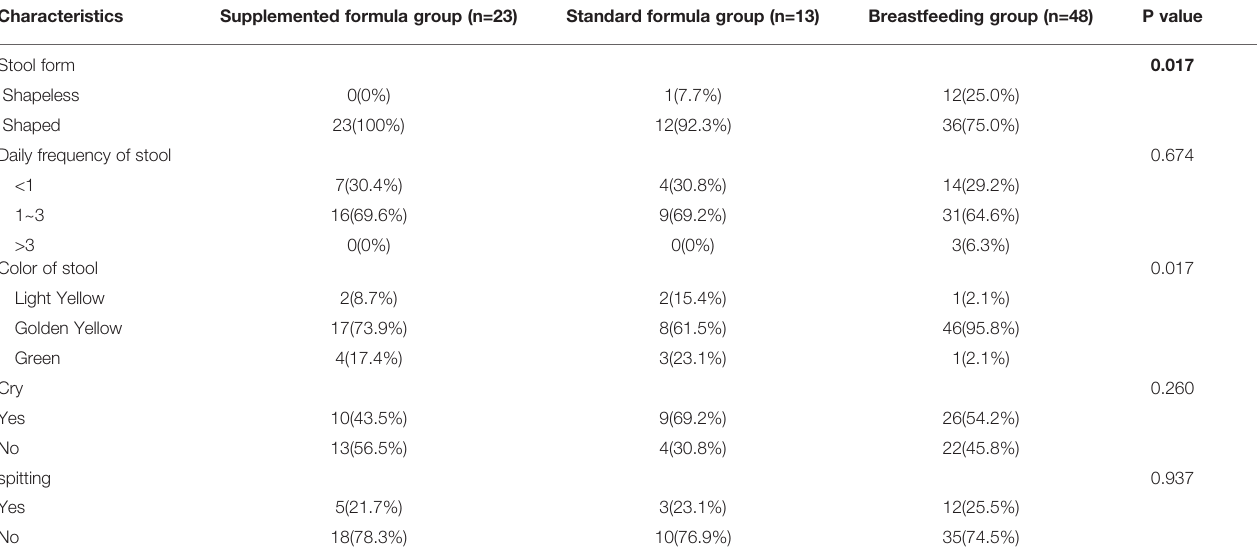
TABLE 3 | Changes in the characteristics of the